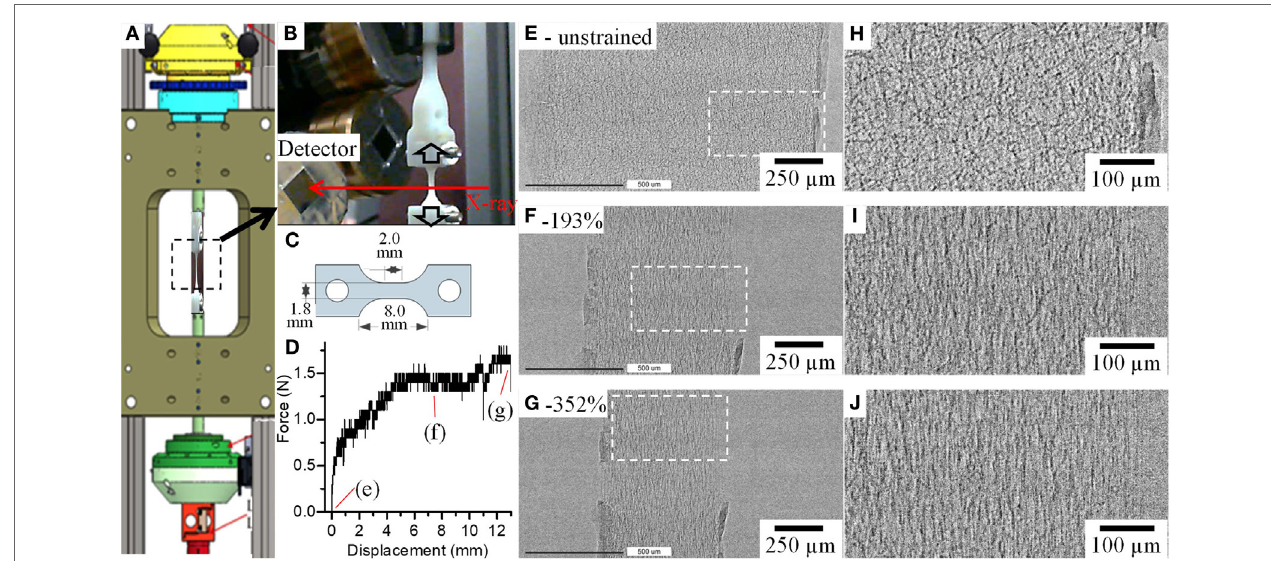
FigUre 2 | (a) P2R tensile tester with (B) fiber mat held together between bespoke grips on the Diamond Manchester Beamline (I13-2) at Diamond Light Source. (c) Dog-bone-shaped samples used for the tests and (D) a force vs displacement curve obtained for the P(3HB-co-4HB) fiber mat. (e–J) show radiographs and magnified images of boxed areas on (e–g) , respectively, of the fiber mats before (e-unstrained), after 7 mm (f-193%) and 13 mm (g-352%)